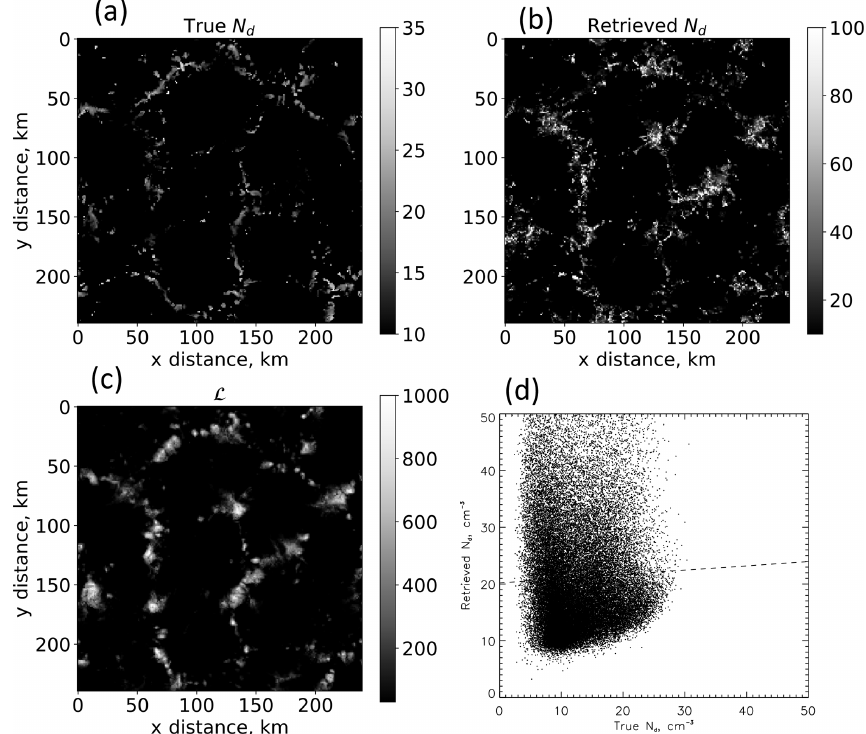
Figure 12. As in Fig. 11 but for an open-cellular case. Note the different scales between (a) and (b) . Mean values of N d in (a) and (b) differ by − 75%. Use of the true N d degrades the S o bias (285% for L2 vs. 803% for L2 N